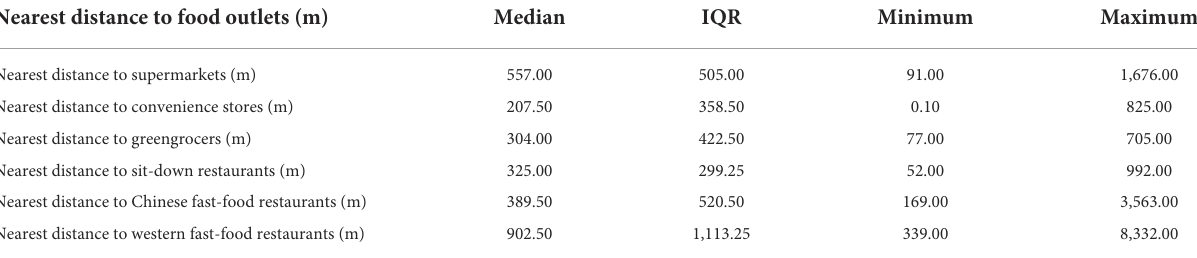
TABLE 4 Participants’ neighborhood food environment proximity